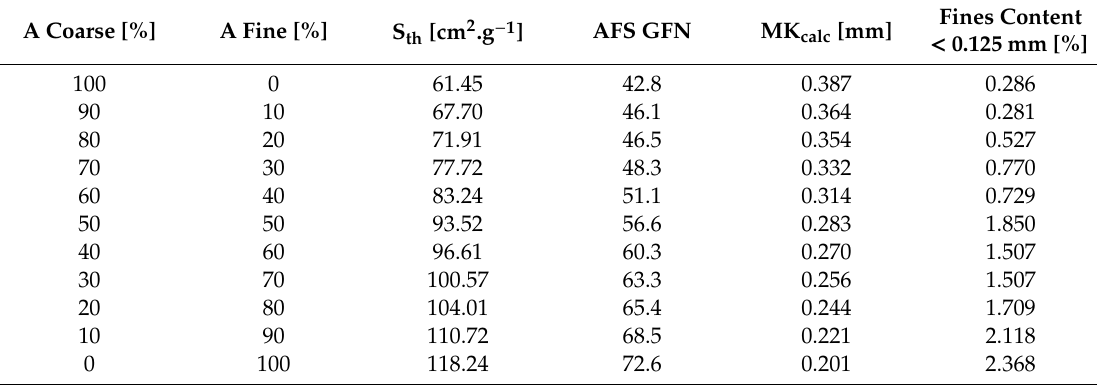
Figure 10. Grain size distribution curves for sands A coarse and D. Table 2. Basic properties of sands A coarse and A fine.